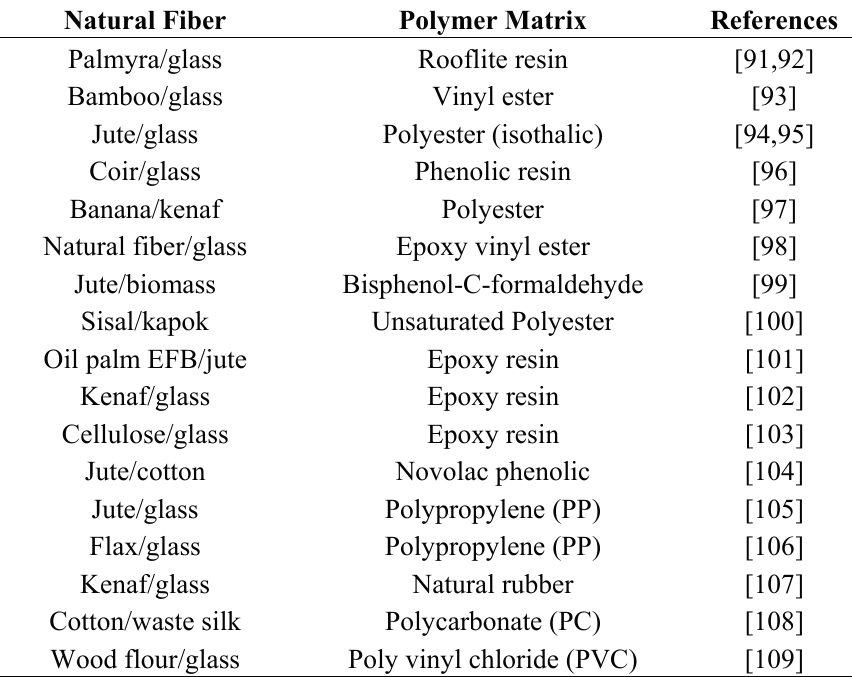
Table 9. Reported work on hybrid